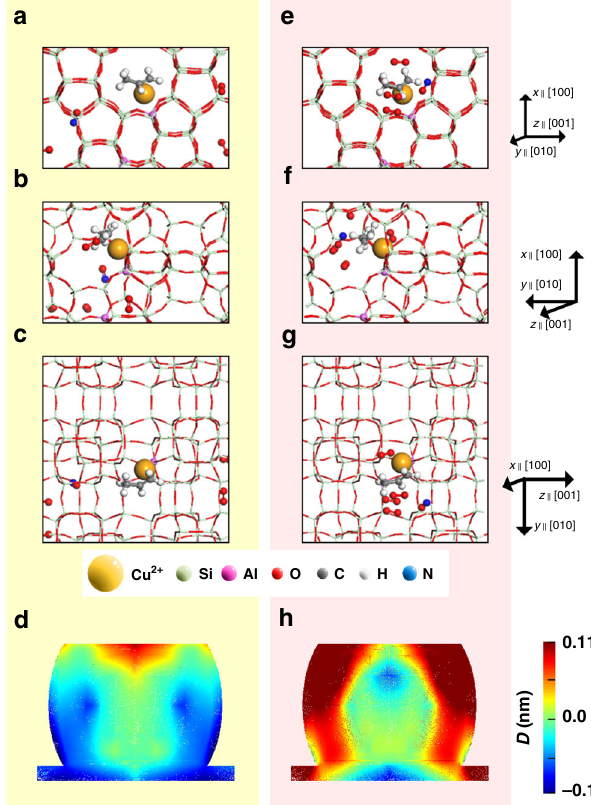
Fig. 4 Stabilized atomic positions from DFT calculations and respective FEA simulations in NO x deoxygenation. The simulated atomic positions are viewed along a [010], b [001], and c [100] direction, when NO and O 2 molecules are located in another channel separated from the Cu active sites, and d the respective FEA simulation result. When NO and O 2 are placed near the active site, the simulated atomic positions are viewed along e [010], f [001], and g [100], and h the respective FEA simulation